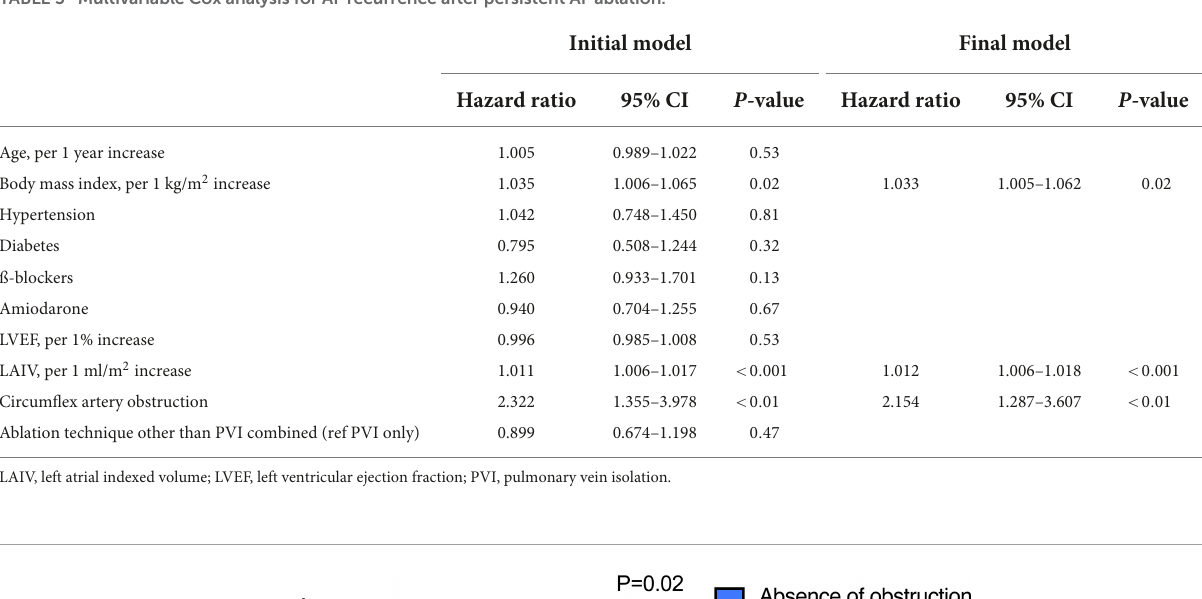
TABLE 3 Multivariable Cox analysis for AF recurrence after persistent AF ablation.